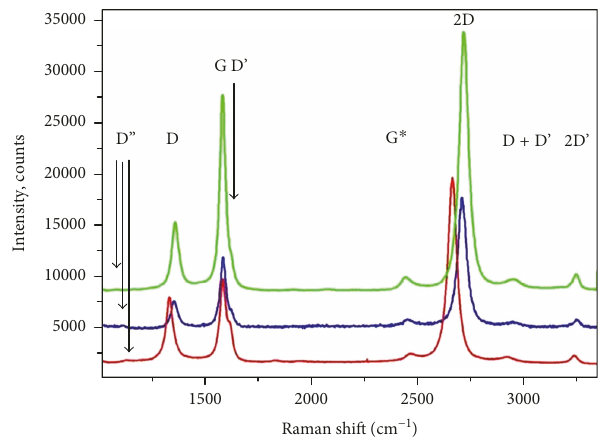
Figure 2: Raman spectra taken from as-grown fi lms excited at 633 nm (red trace), 514nm (blue trace), and 488nm (green trace) laser